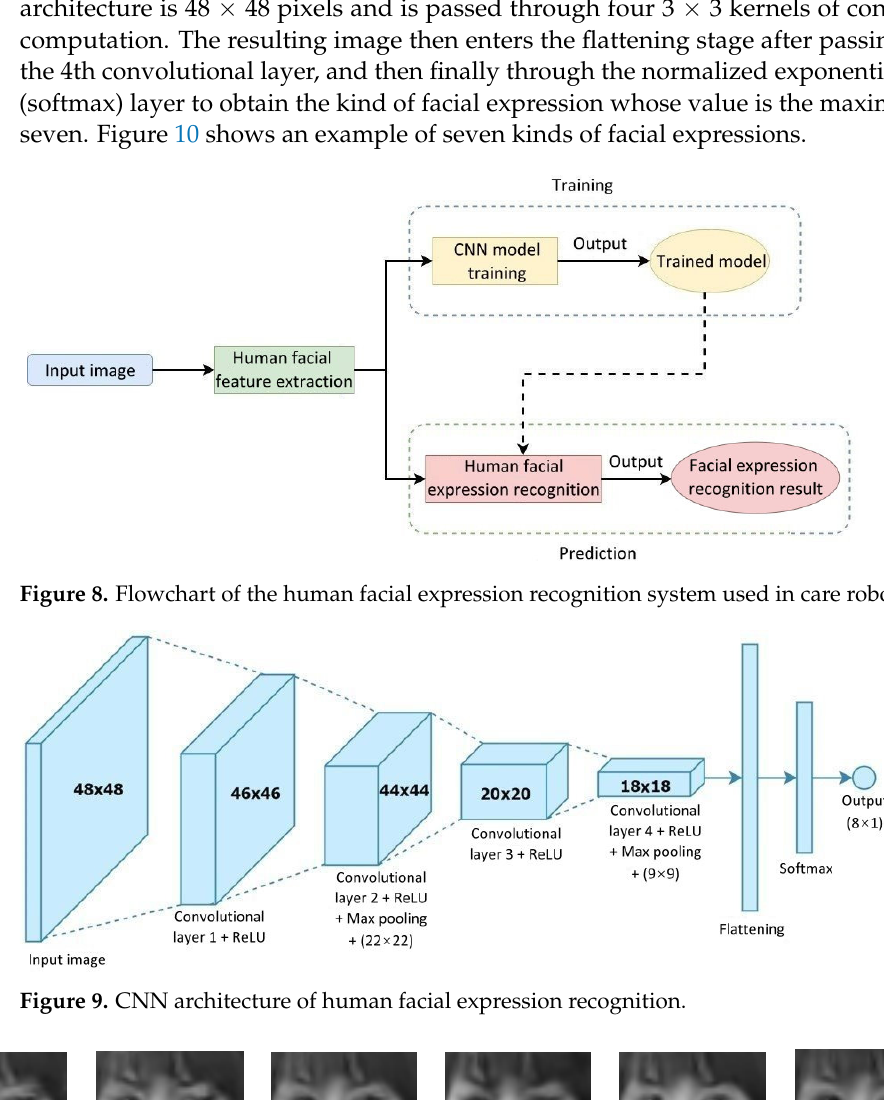
Figure 7. LSTM-based architecture of the elderly fall detection model.